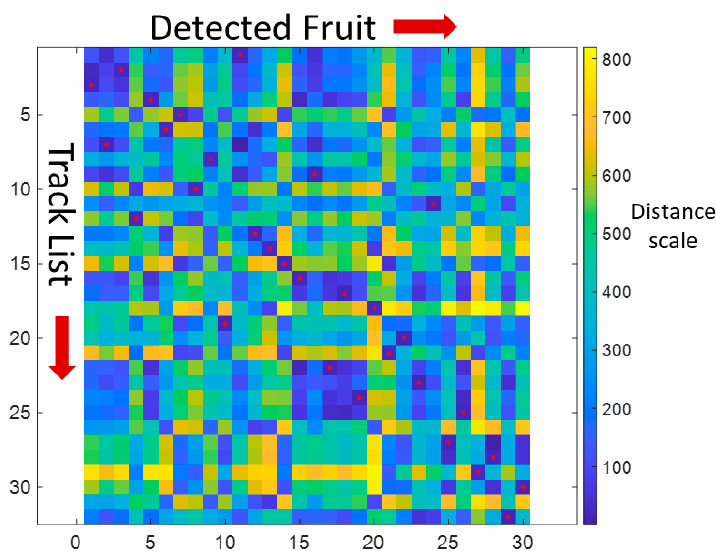
Figure 3. Hungarian assignment for a 32 × 30 cost matrix. X axis represents new fruit (jobs) detected in the image, while the Y axis represents previously detected fruit (workers) present in the track list. In this example data set, the minimum sum cost was 623.